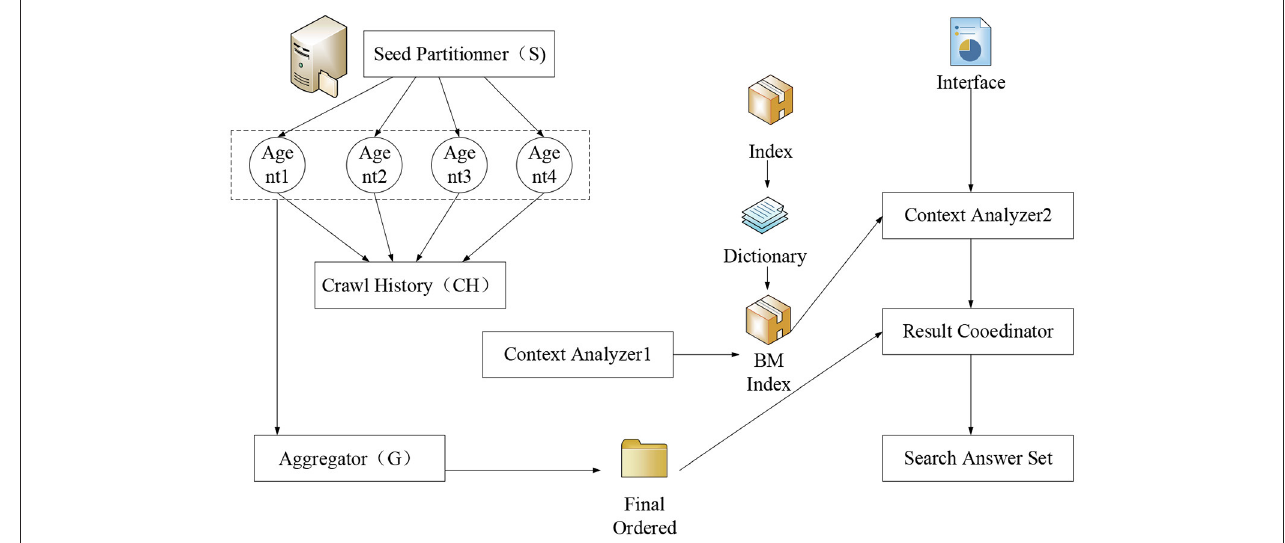
FIGURE 2 | Schematic diagram of web crawler data scraping steps.